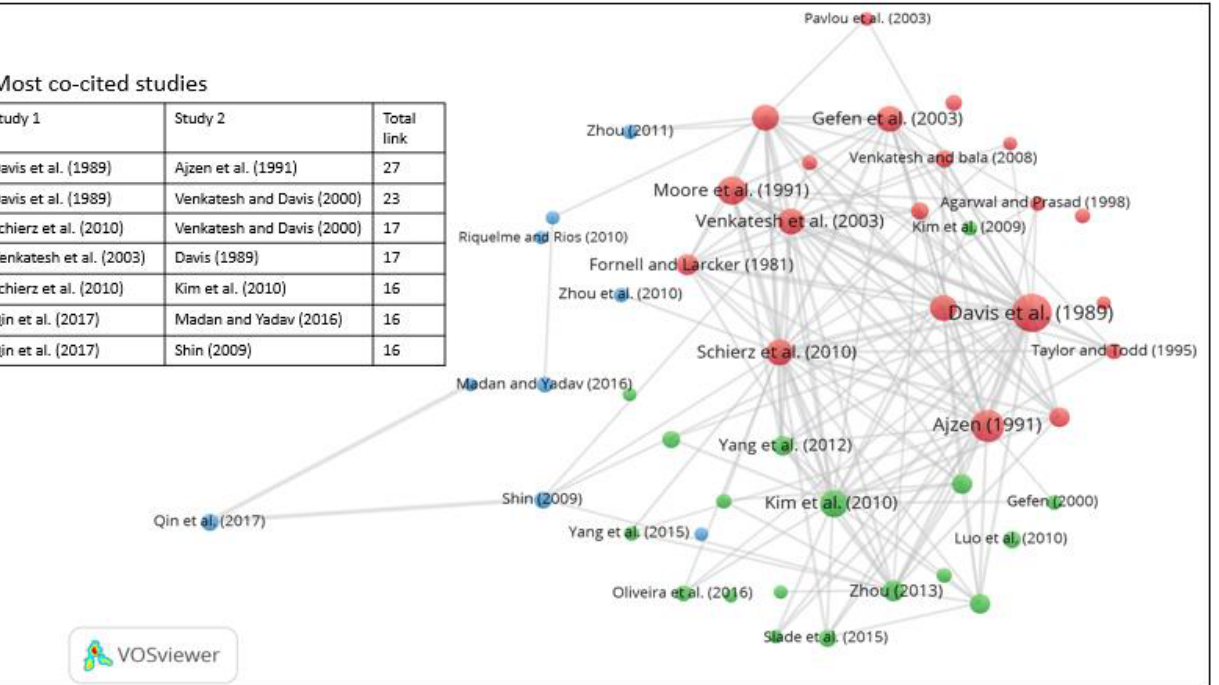
Figure 4. Document pairs with high link strengths.